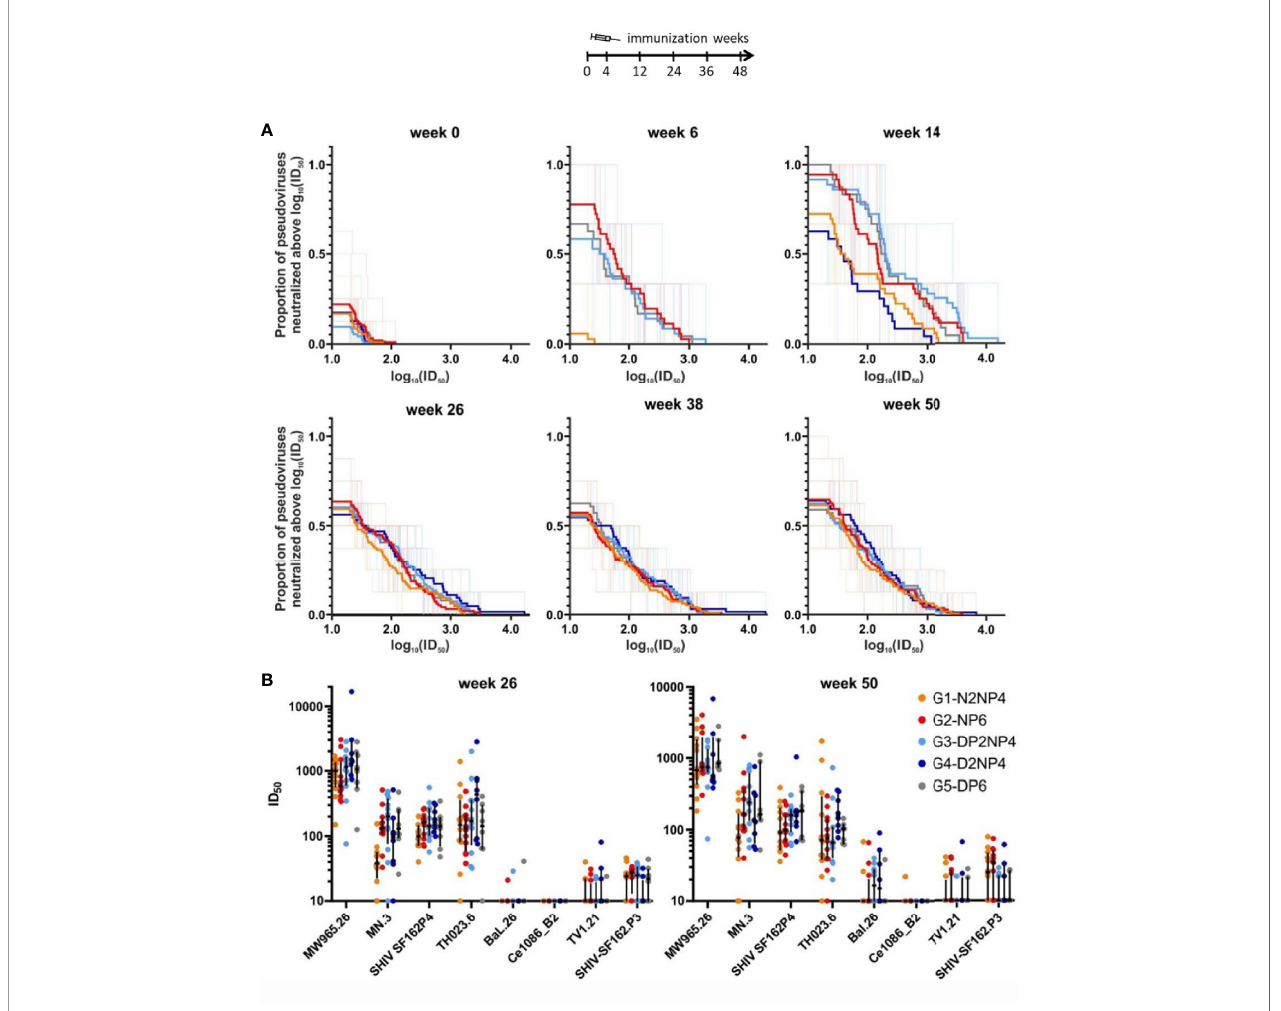
FIGURE 10 | Neutralizing activity of serum samples. (A) Magnitude-breadth plots of log 10 (ID 50 ) against the proportion of neutralized pseudoviruses in a TZM-bl assay. Eight pseudoviruses (MW965.26: clade C, tier 1A; MN.3: clade B, tier 1A; SHIV SF162P4: clade B, tier 1A; TH023.6: clade E, tier 1B; BaL.26: clade B, tier 1B; Ce1086_B2: clade C, tier 2; TV1.21: clade C, tier 2 and SHIV-SF162.P3: clade B, tier 2) were tested at weeks 0, 26, 38 and 50, whereas only three (MW965.26, SHIV-SF162P4 and TH023.6) were tested at weeks 6 and 14. (B) ID 50 values of weeks 26 and 50 samples for neutralization of the different pseudoviruses. Responses of individual monkeys are shown as colored dots and median and interquartile ranges are shown as black